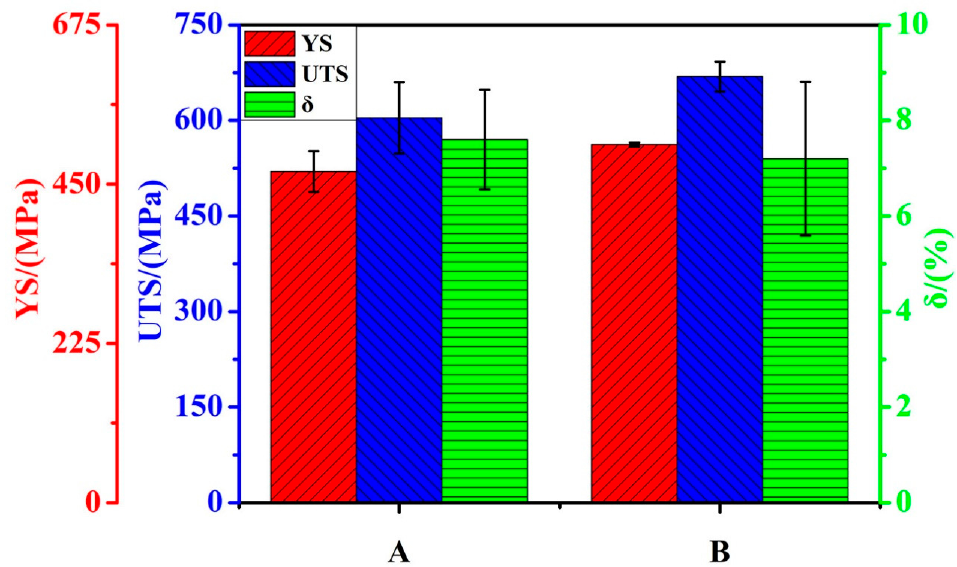
Figure 6. The ultimate tensile strength (UTS), yield strength (YS), and elongation ( δ ) for the as-HIPed alloys A and B at 25 °C.